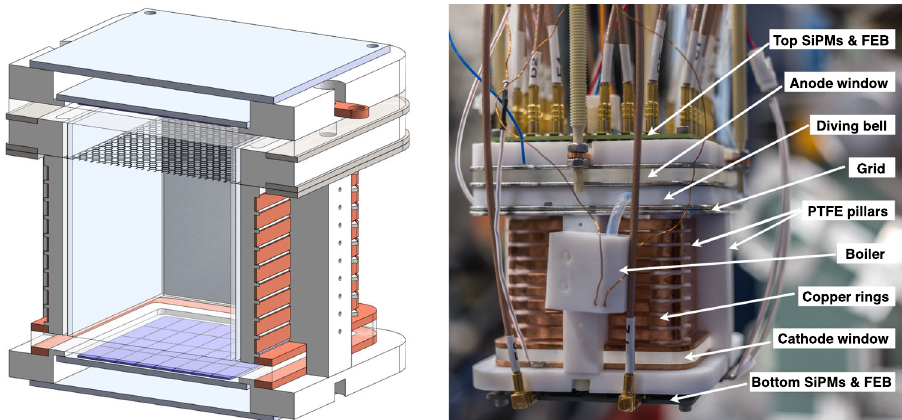
Fig. 2 An open-section drawing ( left ) and a picture ( right ) of the ReD